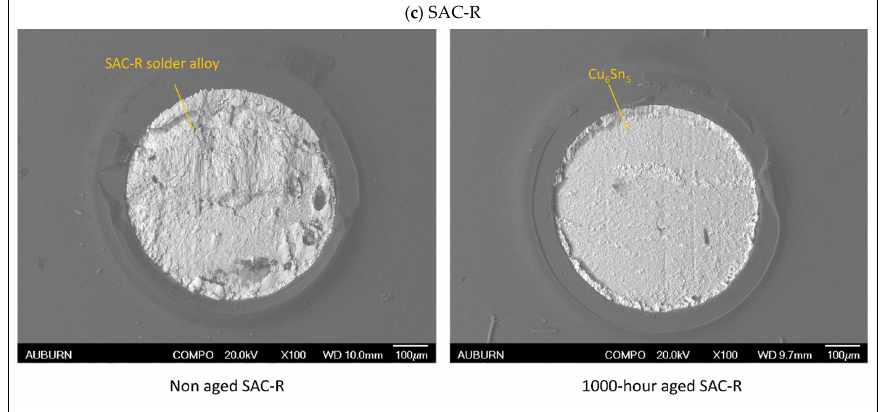
Figure 19. Comparison of aging effect on failure modes for ( a ) SAC305, ( b ) SAC-Q, and ( c ) SAC-R. Materials 2023 , 16 , x FOR PEER REVIEW It is worth noting that the EDS analysis was performed to identify each phase sepa- rately by acquiring and analyzing data for each spectrum separately. Furthermore, using electron backscatter diffraction (EBSD), we can distinguish between the IMC precipitate since Ag (47: atomic number) has brighter contrast compared to Cu (27: atomic number). Energy dispersive X-ray (EDS) spectrum analysis of Cu 6 Sn 5 and Ag 3 Sn was performed for each alloy after reflow and at 1000 h of aging times, as indicated in Figure 20.